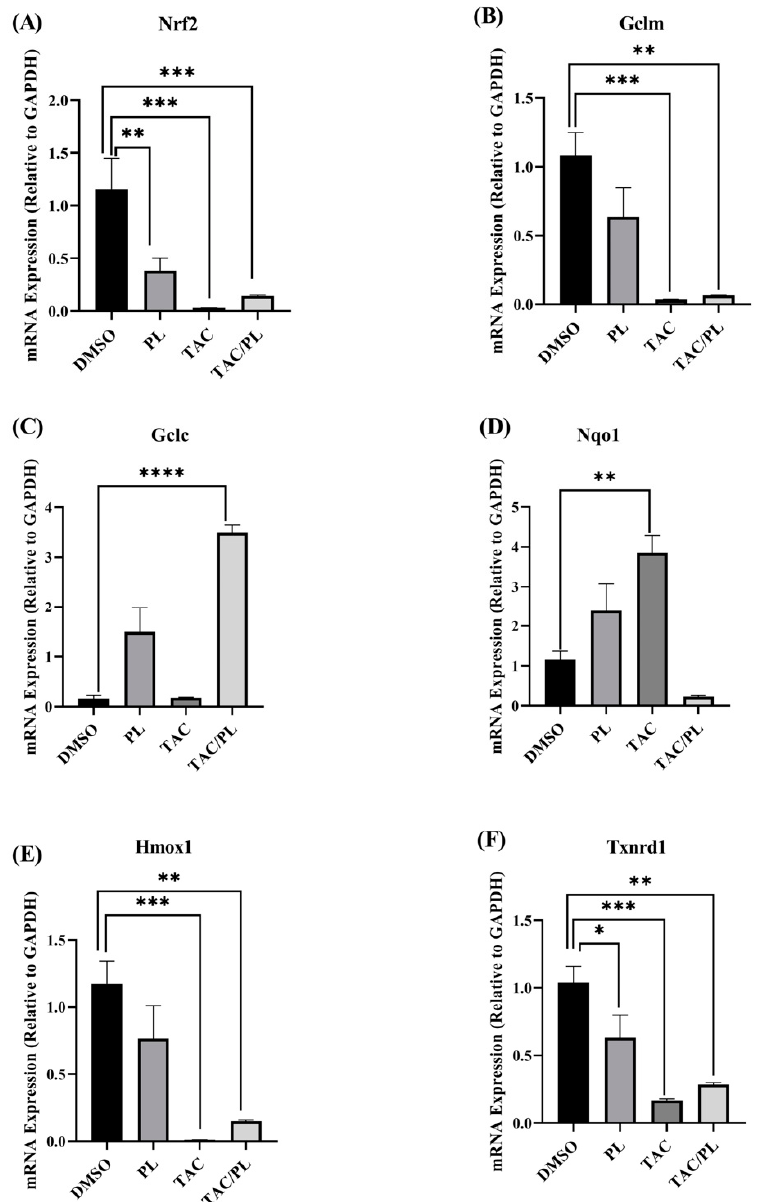
Figure 7. Changes in mRNA expression of Nrf2 cytoprotective target genes. ( A ) PL, TAC, and TAC/PL treatments reduced expression of Nrf2. ( B ) PL, TAC, and TAC/PL treatments reduced expression of GCLM. ( C ) TAC and TAC/PL treatments increased expression of GCLC. ( D ) TAC treatment increased expression of Nqo1. ( E ) TAC and TAC/PL treatments reduced expression of Hmox1. ( F ) PL, TAC, and TAC/PL treatments reduced expression of Txnrd1. One-way ANOVA, average ± SEM; Bonferroni multiple comparisons * p < 0.05, ** p < 0.01, *** p < 0.001, **** p < 0.0001. DMSO, n = 7; PL, n = 9; TAC, n = 8; TAC/PL, n = 6.